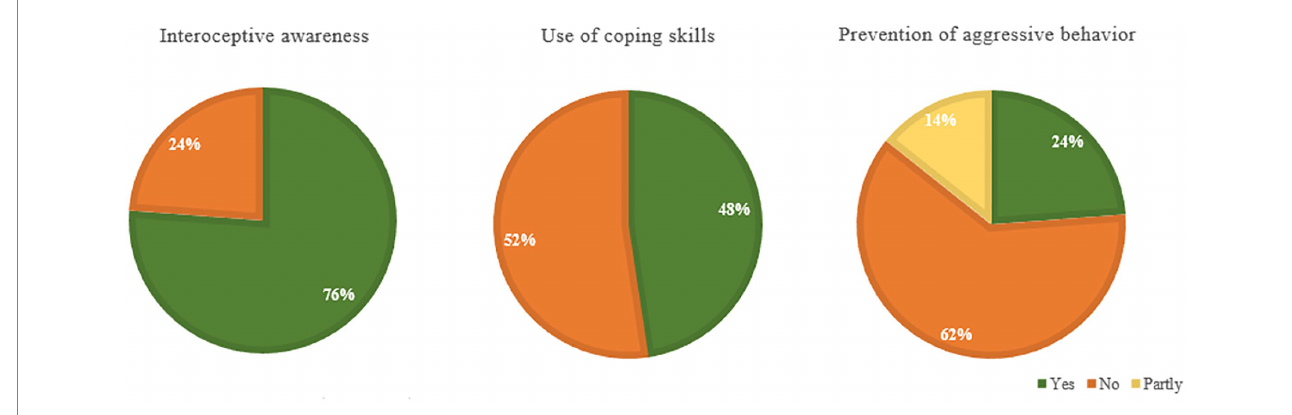
FIGURE 8 Perceived effectivity of the Sense-IT app on interoceptive awareness, use of coping skills and prevention of aggressive behavior according to forensic